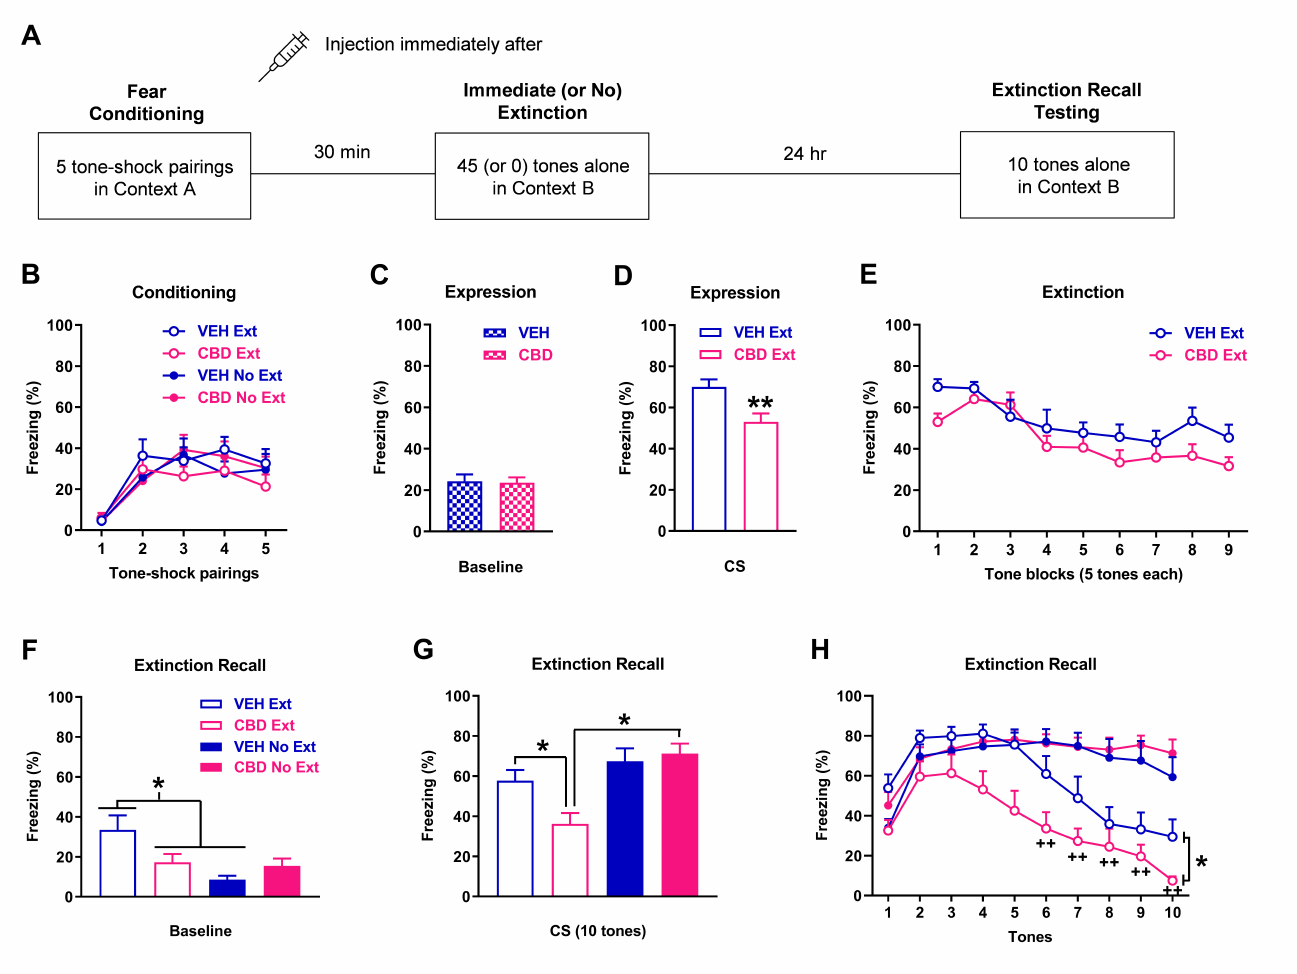
Figure 3. Effects of cannabidiol (CBD; 10 mg/kg) on freezing during immediate extinction and